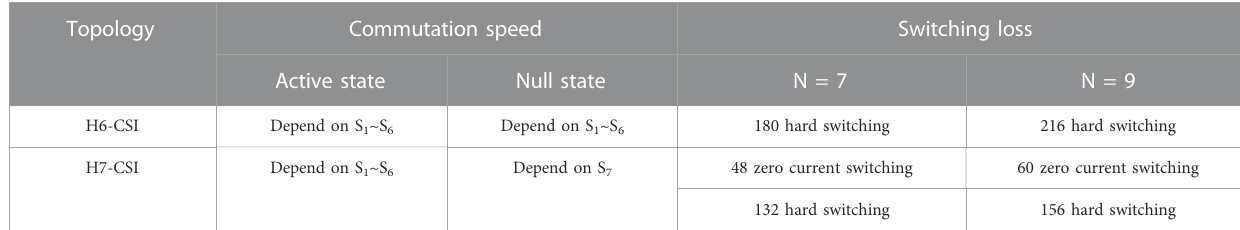
TABLE 1 Comparison of switching characteristics in one period.